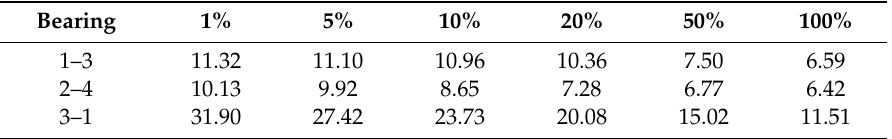
Table 10. FEMTO RMSE Results—Semi-supervised Feature Learning with Semi-Supervised regression.